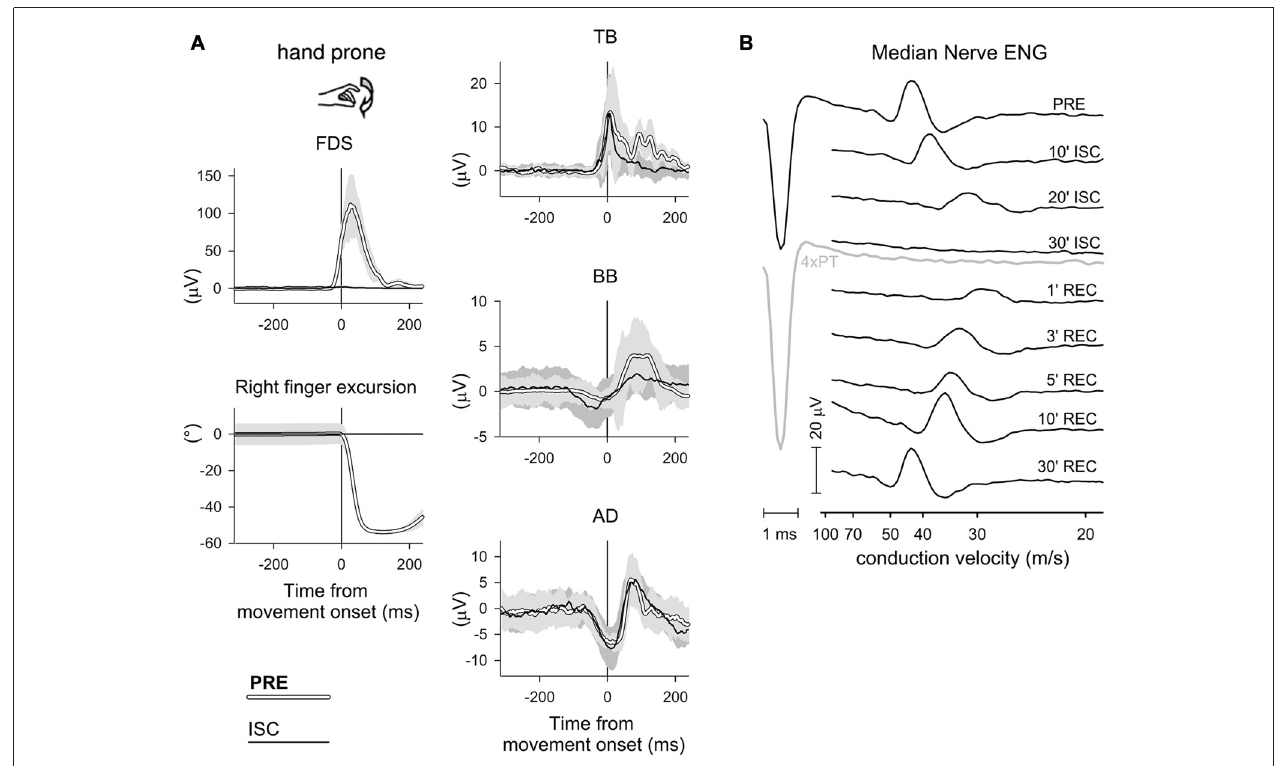
FIGURE 8 | APA persistence under ischemia. (A) Rectified and integrated average recordings of index-finger prime mover EMG and of intra-limb APAs, before and during ischemic block of the median nerve at the forearm. One representative subject. Time 0: movement onset of the left index-finger. When rapidly flexing both index-fingers before ischemia (PRE, white traces, SD in light gray), the right prime mover FDS was activated and the right arm equilibrium was preserved, thanks to an excitatory APA in TB and inhibitory APAs in BB and AD. Under ischemia of the right forearm (ISC, black traces, SD in dark gray), FDS activation and index-finger movement were both suppressed, while excitatory APAs in TB and inhibitory APAs in BB and AD were still evident and qualitatively similar to those recorded in PRE. (B) Electroneurogram (ENG) of the right median nerve of one representative subject, showing the effect of ischemia, induced by a pressure cuff, on the afferent volley elicited by electrical stimulation of the index-finger skin (3 × perception threshold, PT). Ischemia progressively reduced the volley amplitude until reaching complete suppression after 30 min (even increasing stimulation to 4 × PT, gray trace, did not elicit a response). After removing the pressure cuff, the effect of ischemia completely recovered in 30 min. Reproduced from Bruttini et al. (2014), © Springer-Verlag Berlin Heidelberg 2014, with permission of Springer